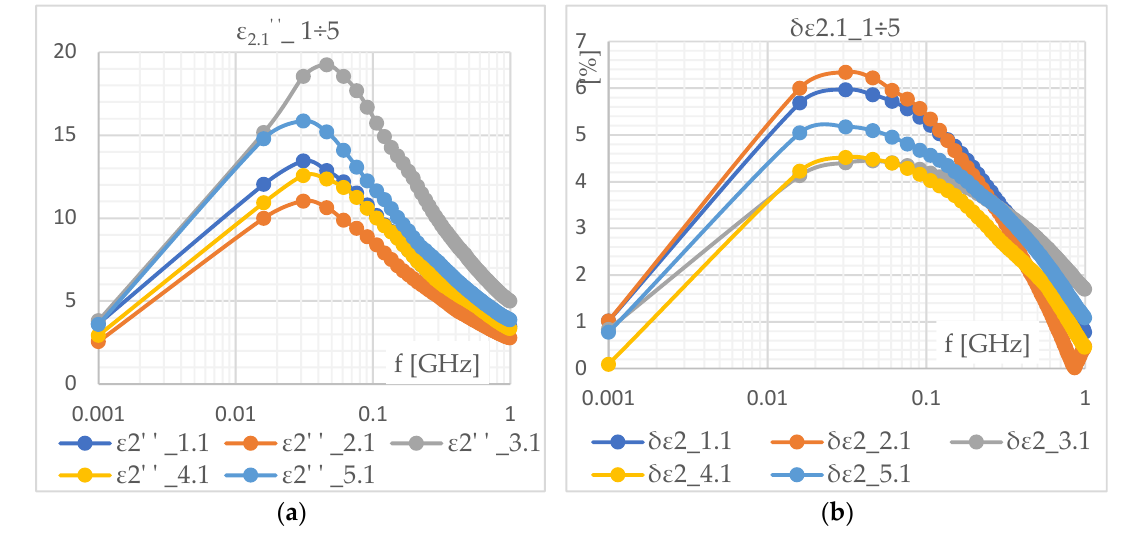
(cid:48)(cid:48) calculated as per (13); ( b ) the error of δε 2.1 calculations for the loss 2.1